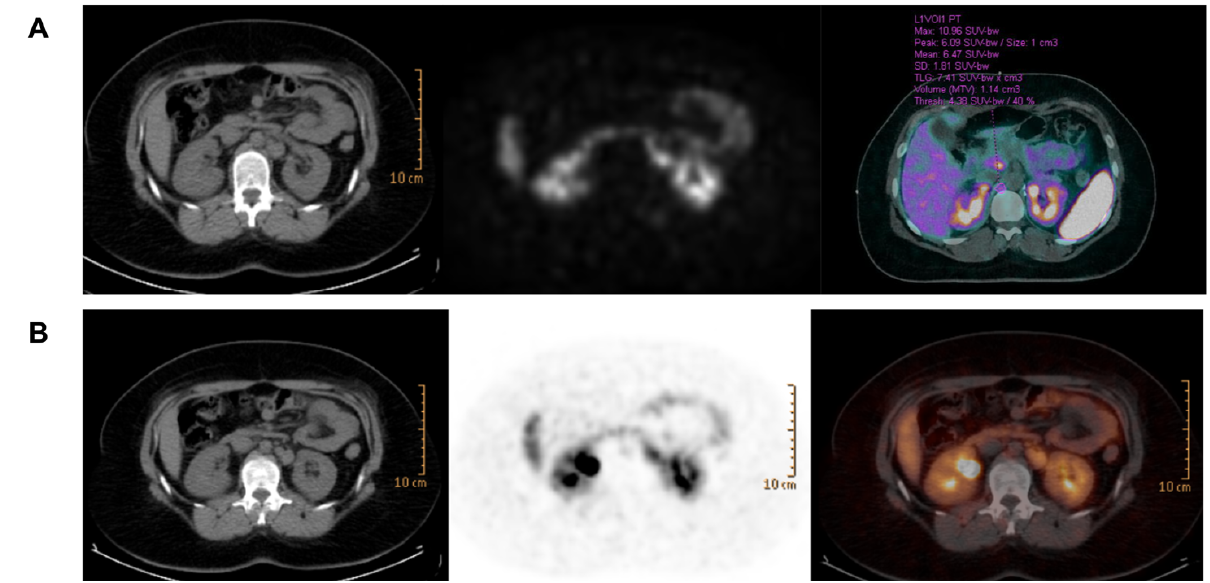
Figure 3. ( A ): 68Ga-DOTATATE pre therapy (21 February 2019): retrocrural right lymph node (SUVmax 11), posterior left renal artery lymph nodes (SUVmax 19.6), and retropancreatic lymph node (SUVmax 10.7). ( B ): 68Ga-DOTATATE pre therapy (28 June 2021): retrocrural right lymph node (SUVmax 6), posterior left renal artery lymph nodes (SUVmax 8.9–4.8), and retropancreatic lymph node (SUVmax 6.5).